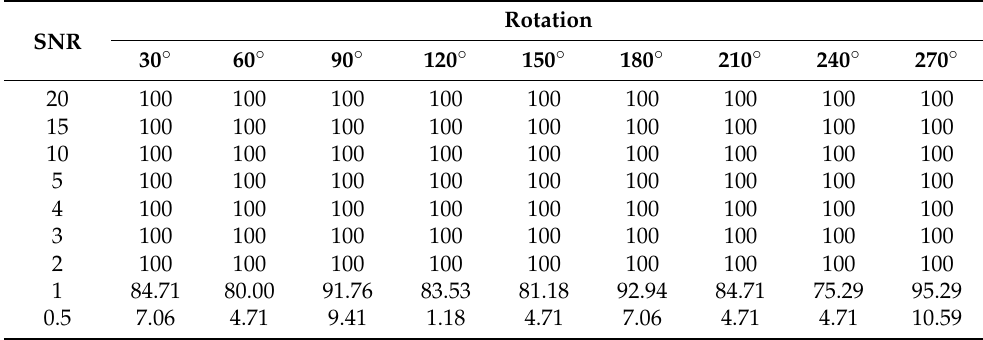
Table 8. The correct recognition rates for a combination of rotation angles and noise levels for the log-polar-FFT2 method for the printed Chinese character dataset.